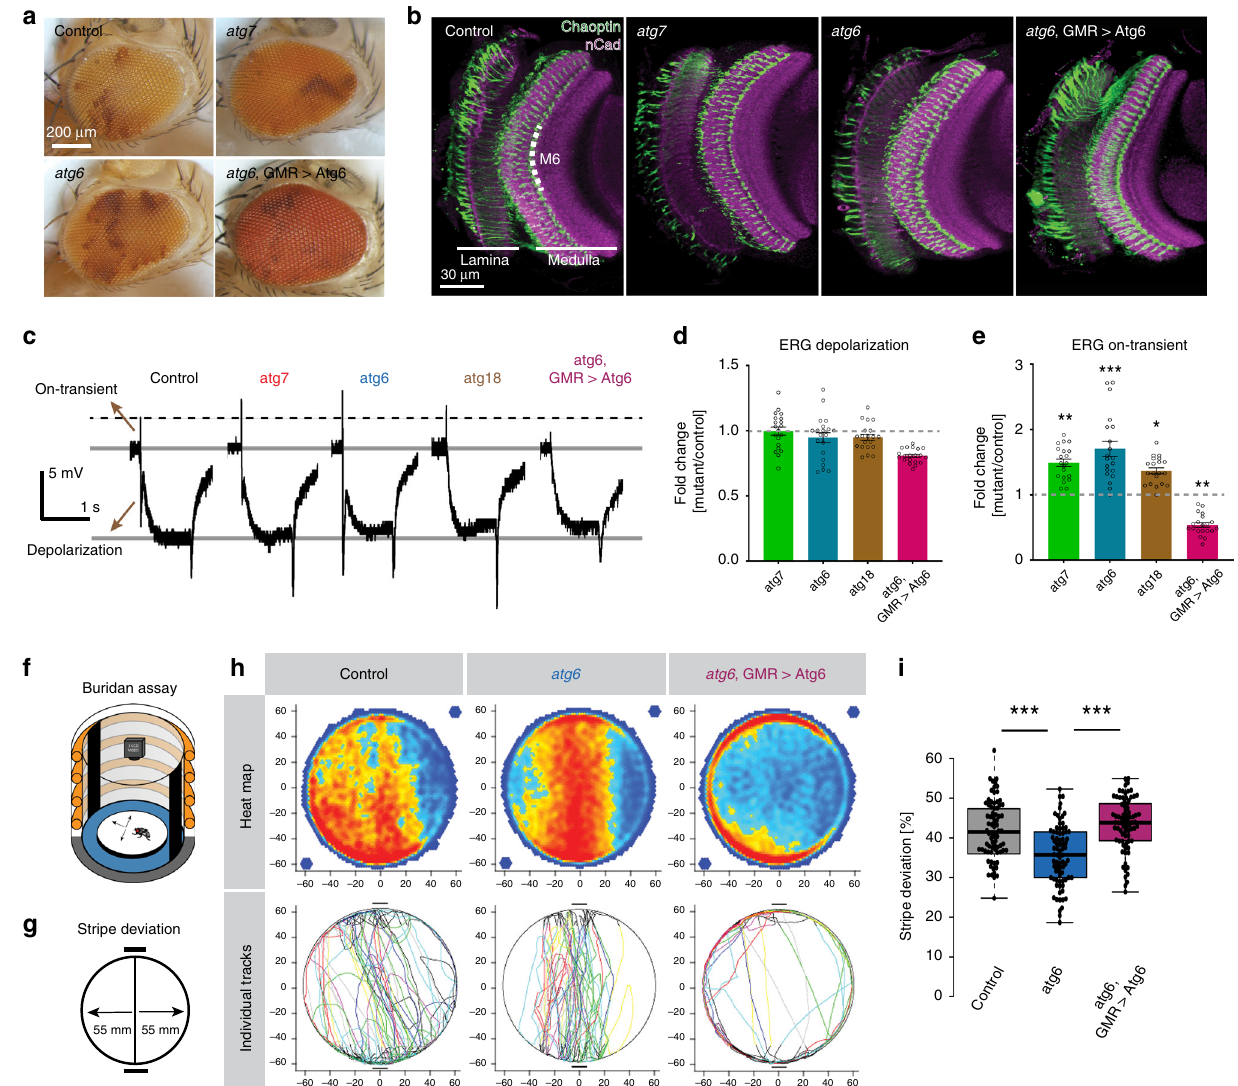
Fig. 1 Autophagy de fi ciency in Drosophila photoreceptors leads to increased neurotransmission and visual attention. a , b Newly hatched (0-day-old) genetic mosaic fl ies with autophagy-de fi cient ( atg6 and atg7 mutants) photoreceptors exhibit normal eye morphology ( a ) and axonal projections in the optic lobe ( b ). Repeated three times independently. c Representative electroretinogram (ERG) traces. Repeated three times independently. d , e Quanti fi cation of ERG depolarization ( d ) and on-transient ( e ) amplitudes relative to control. Rescue of atg6 mutant photoreceptors with GMR > atg6 expression leads to overcompensation and increased autophagy (see Supplementary Fig. 1). n = 20 fl ies per condition. Two-tailed unpaired t -test with Welch ’ s correction; * p < 0.05, ** p < 0.01, *** p < 0.001. Error bars denote mean ± SEM. f Buridan ’ s paradigm arena to measure object orientation response of adult fl ies, with two black stripes positioned opposite to each other as visual cues. g The parameter “ stripe deviation ”’ measures how much a fl y deviates from a straight path between the black stripes in the arena. h Stripe fi xation behavior of adult fl ies with atg6 mutant photoreceptors, photoreceptors with upregulated autophagy ( atg6 , GMR > Atg6), and their genetically matched controls are shown on the population level (heatmap) and as individual tracks. Flies with atg6 mutant photoreceptors show reduced stripe deviation, whereas increased autophagy ( atg6 , GMR > Atg6) leads to increased stripe deviation. i Quanti fi cation of stripe deviation. The error bars indicate the 25th percentile, the boxed area the 75th percentile, and the middle line of the boxplots indicates the median. n = 60 fl ies per condition, two-way ANOVA and Tukey ’ s HSD as post-hoc test; *** p < 0.001. Source data are provided as a Source Data fi